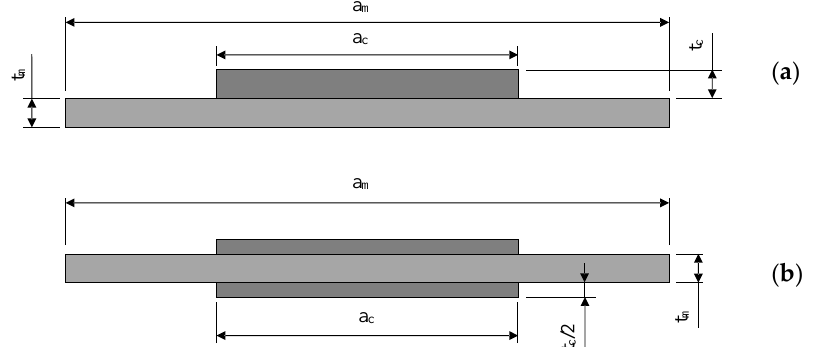
Figure 3. Possible shape forms that the repair patch can have: ( a ) rectangular, ( b ) ellipsoid, ( c ) octagonal horizontal, ( d ) octagonal vertical.